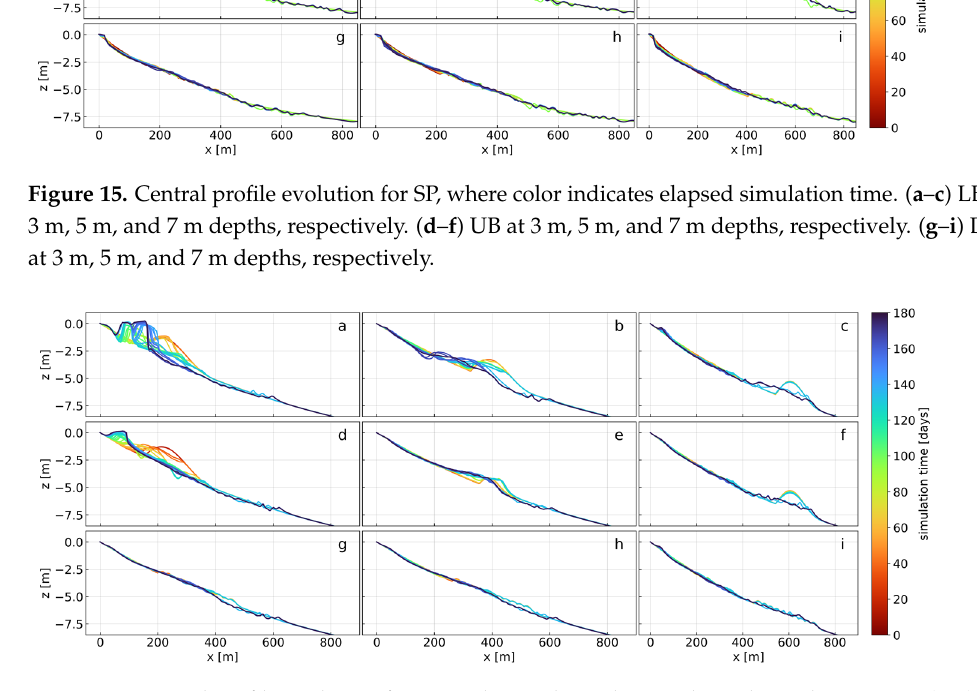
Figure 16. Central profile evolution for OD, where color indicates elapsed simulation time. ( a – c ) LB at 3 m, 5 m, and 7 m depths, respectively. ( d – f ) UB at 3 m, 5 m, and 7 m depths, respectively. ( g – i ) DM at 3 m, 5 m, and 7 m depths, respectively.